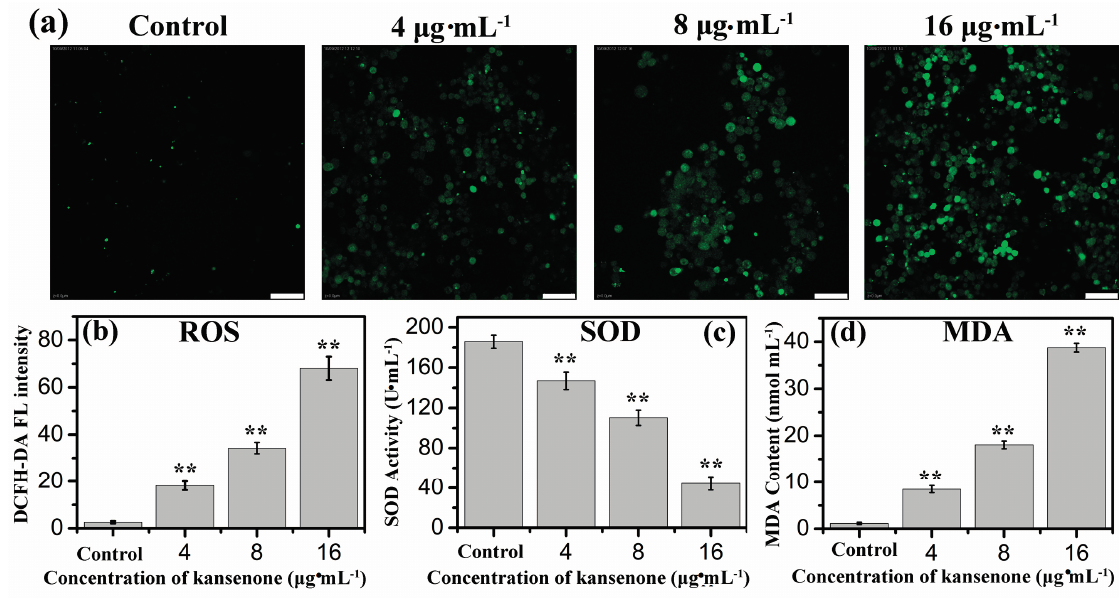
Figure 4. ( a ) Fluorescence images of ROS generation and effects of kansenone on cellular; ( b ) ROS; ( c ) SOD and ( d ) MDA levels. The scale bar is 50 μ m. Compared with corresponding control group, ** p <